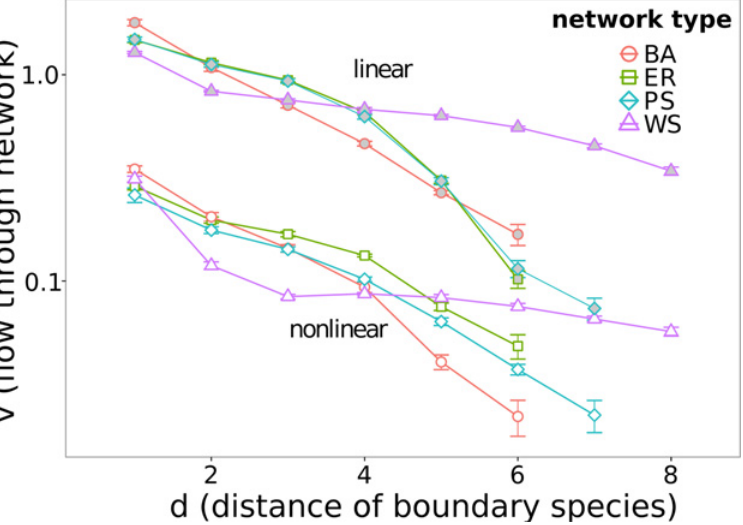
Fig 3. The flow v through the network depending on boundary species distance d . All networks are simulated with a boundary concentration difference of j c 1 − c 2 j = 0.9 and a base concentration of min ( c 1 , c 2 ) = 0.1. Filled (grey) symbols represent linear networks, empty (white) the nonlinear ones. Error bars show the standard error of the